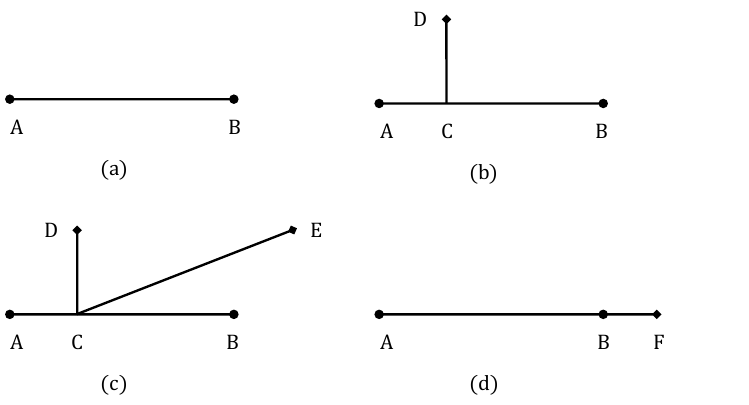
Figure 7. PL System connection scenarios: ( a ) Scenario 1, ( b ) Scenario 2, ( c ) Scenario 3, and ( d ) Scenario 4.